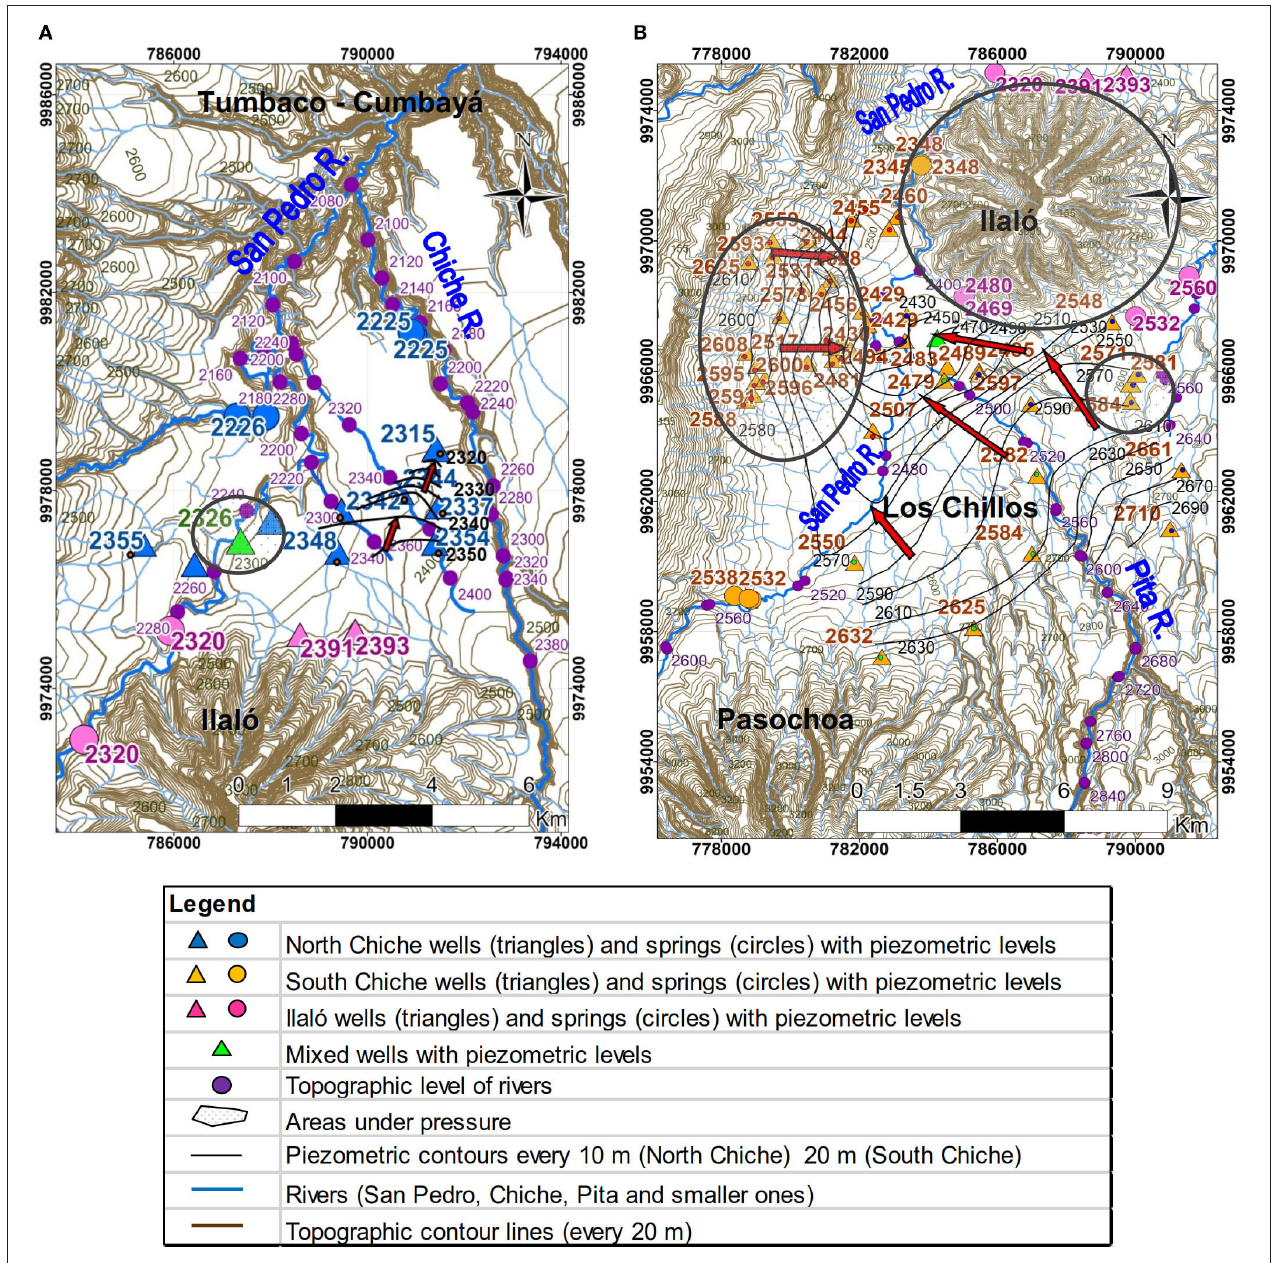
FIGURE 2 | Piezometric maps (local measured values in colors, interpolated contour lines in black lines and black numbers): (A) North Chiche aquifer between September 2009 and October 2012, (B) South Chiche aquifer between February 2011 and October 2012.